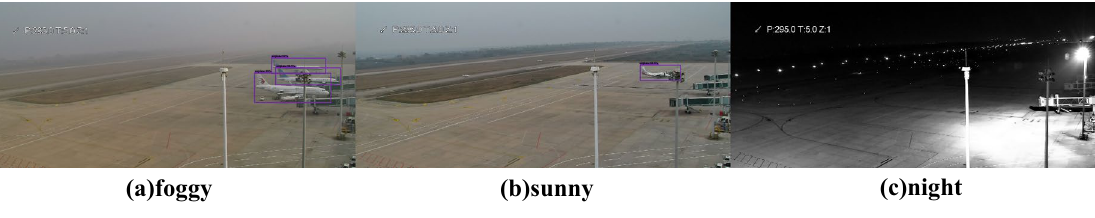
Figure 10. YOLOX-Tiny detection renderings in different